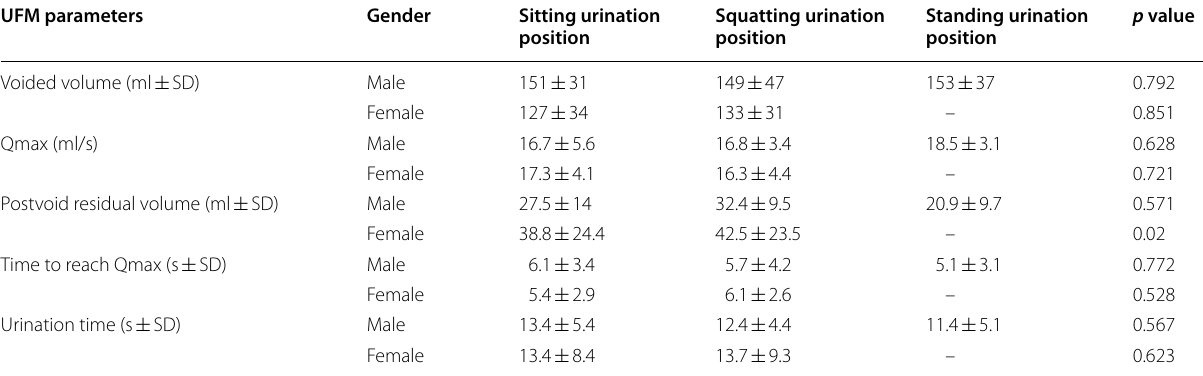
Table 1 Uroflowmetry parameters recorded in group 1 (consisted of males and females with voiding dysfunction) in three different